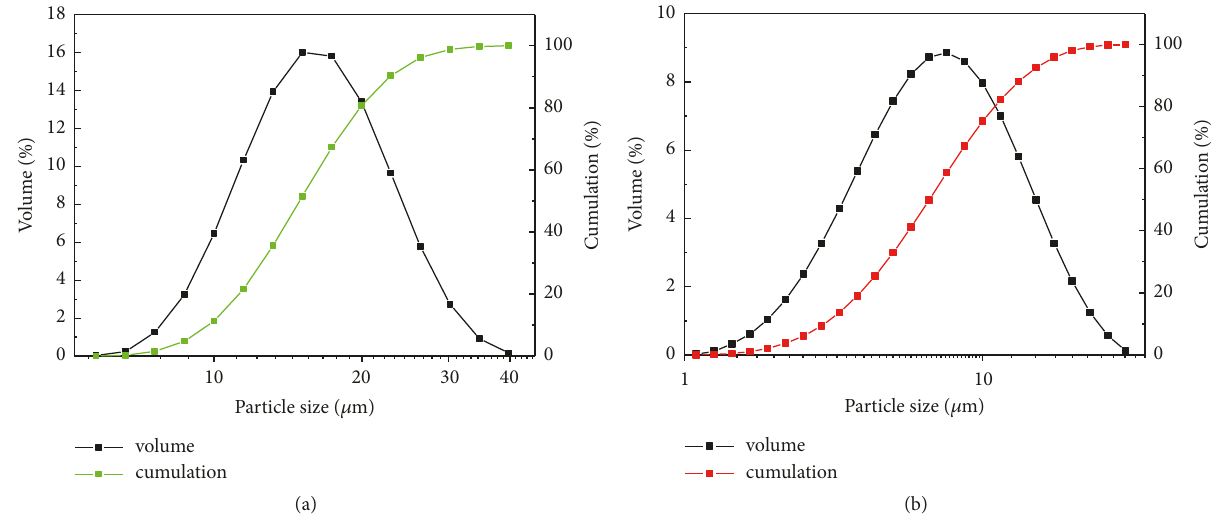
Figure 4: Measured phosphor particle size distribution (a) green phosphor; (b) red